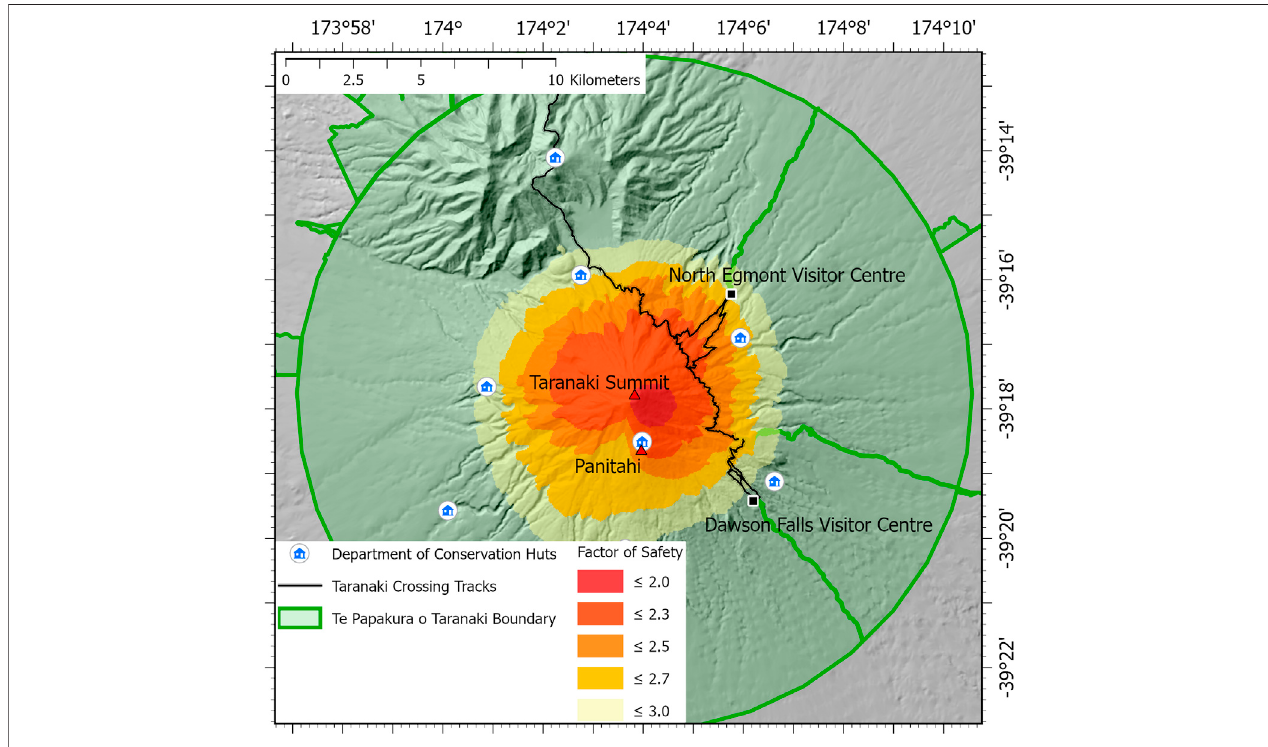
FIGURE 9 | Minimum factor of safety for Mt. Taranaki edi fi ce, calculated using Bishop ’ s simpli fi ed method in 3D.